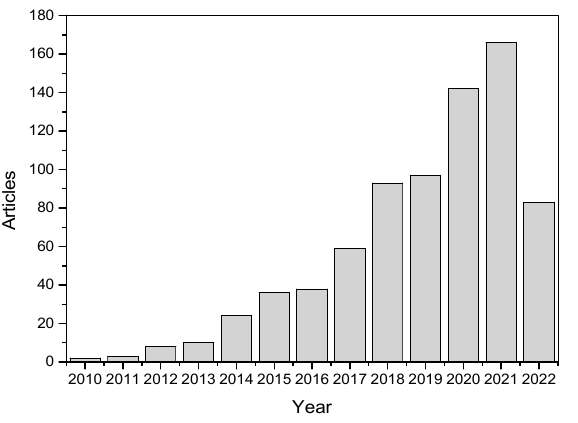
Figure 1. Number of research articles published on multi-material additive manufacturing after 2010 (source: Scopus).